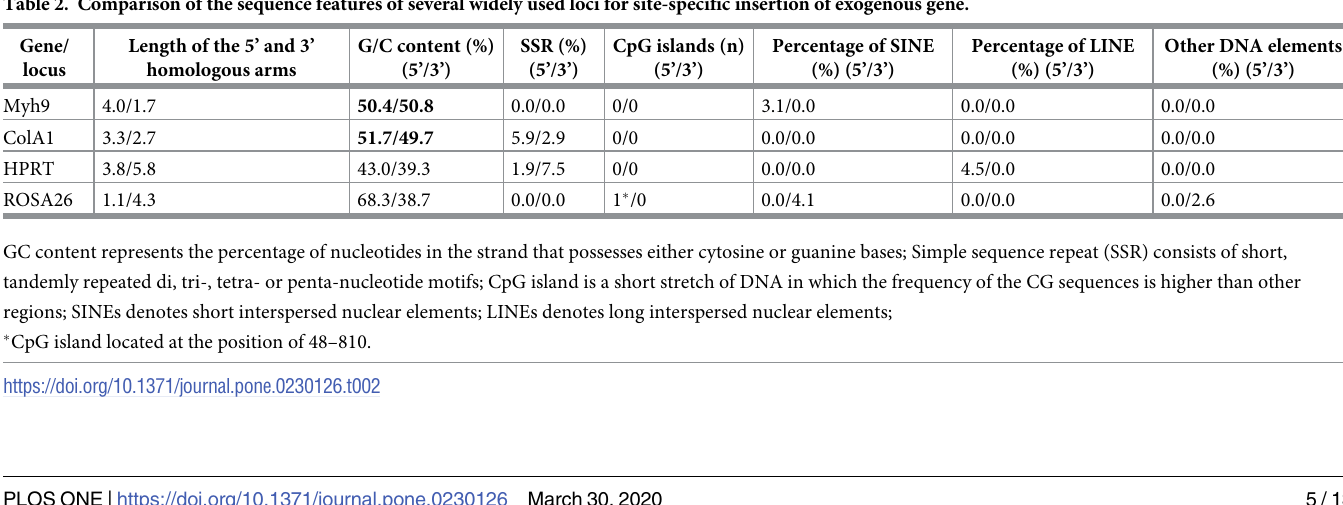
Table 2. Comparison of the sequence features of several widely used loci for site-specific insertion of exogenous gene. Gene/ Length of the 5’ and 3’ G/C content (%) locus homologous arms (5’/3’)